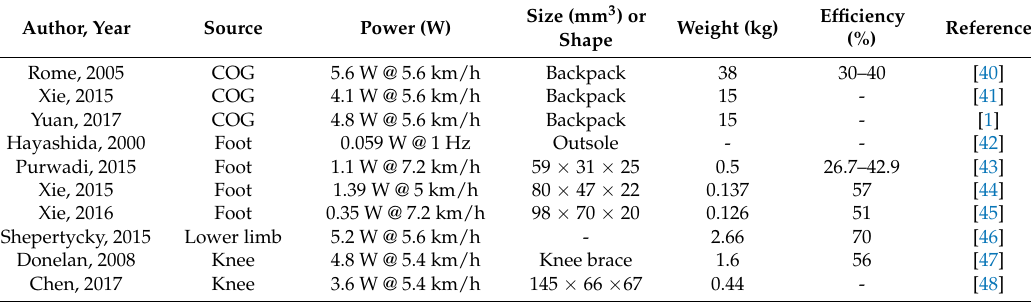
Table 5. Wearable electromagnetic energy harvesters